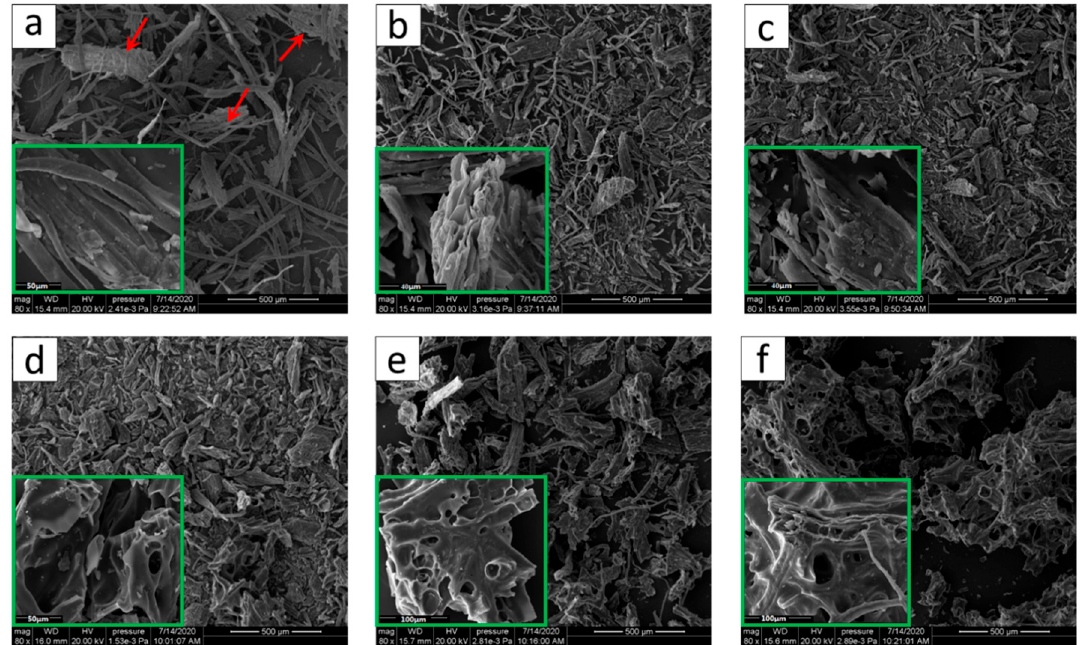
Figure 6. The morphology changes in chars from the co-pyrolysis of fiberboard and glucose at 500 °C: ( a ) FB; ( b ) char from FB; ( c ) char from FB with 10% glucose; ( d ) char from FB with 30% glucose; ( e ) char from FB with 50% glucose; ( f ) char from FB with 70% (the photos inside the green box show higher magnification).